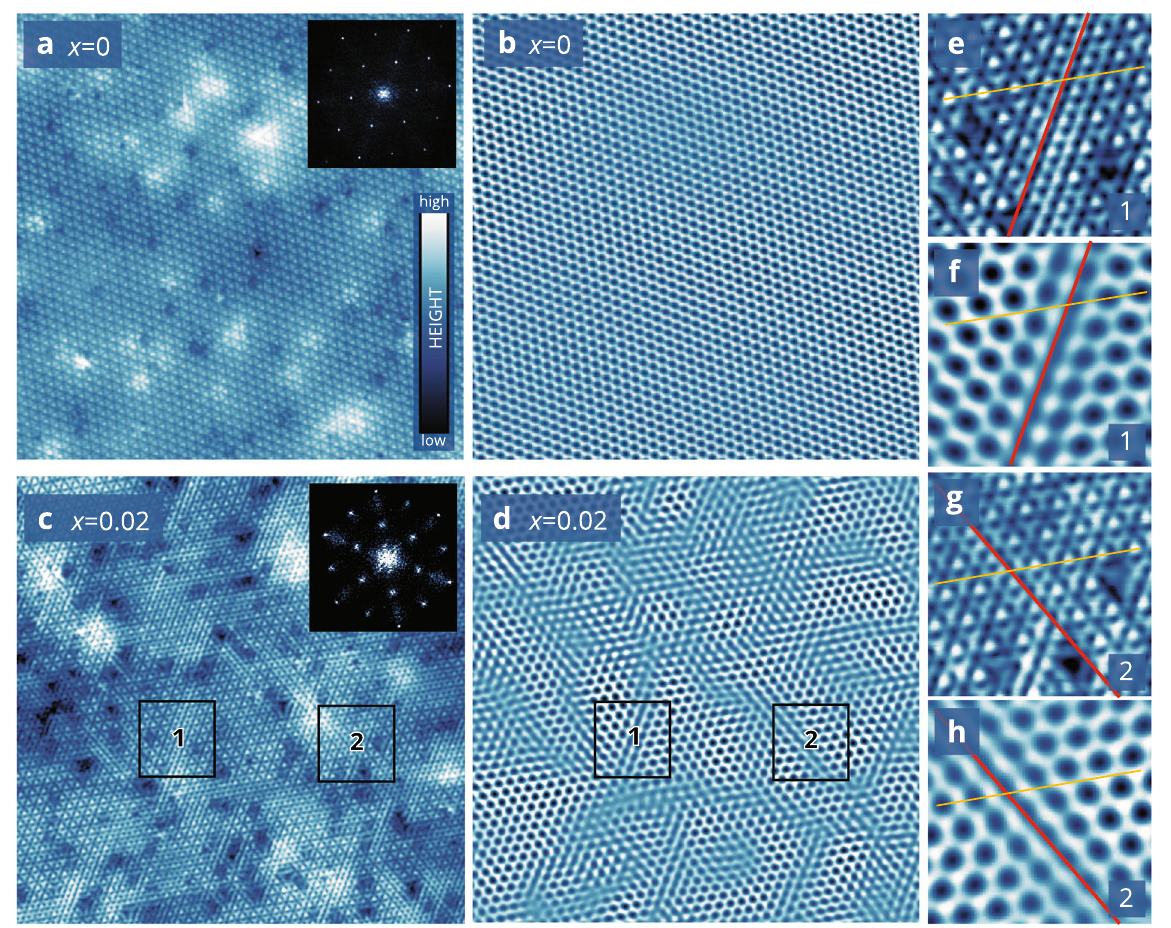
Fig. 5 CDW domain walls. a 30 nm × 30 nm area recorded at 4 K, 100 mV, and 20 pA, for 0% Pt doping. The inset shows the Fourier transform of the topography. b Selective inverse Fourier transform of CDW peaks calculated from a . Consistent with previous STM data on pristine samples, the domain wall density is very low. In fact, there are no domain walls in this area. c 30 nm × 30 nm area recorded at 300 mK, 100 mV, and 20 pA, for 0.02% Pt doping. The inset shows the Fourier transform. d Selective inverse Fourier transform of CDW peaks calculated from c . A network of domain walls (seen as short streaks in the principle crystalline directions) is visible. e – h Magni fi ed views of the smaller rectangular areas shown in c and d indicated as 1 and 2 are shown in ( e and f ) and 2 ( g and h ), respectively. The red lines indicate CDW domain walls. The orange lines indicate the π -shift between two CDW domains. The phase shift can be seen clearly in e and g by tracking the positions of the atoms across the domain